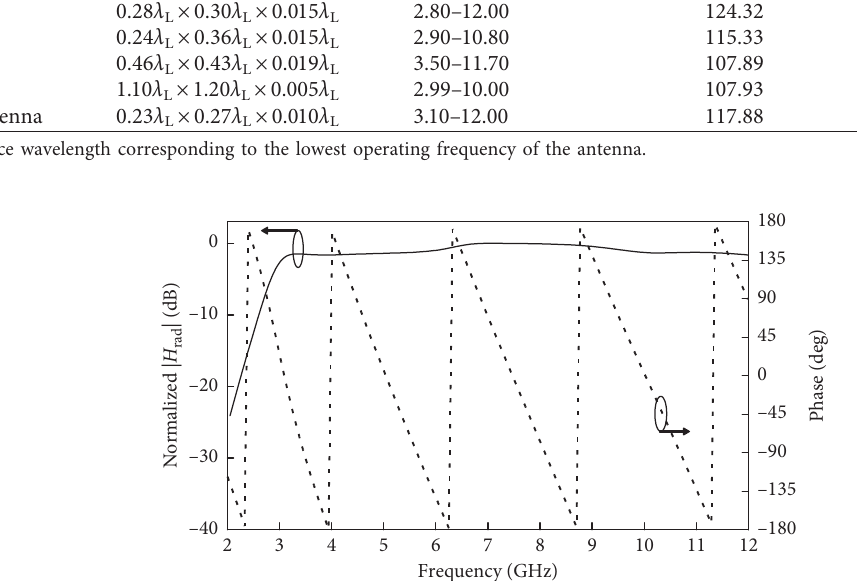
Figure 15: Simulated | H rad | of the antenna in the boresight direction.